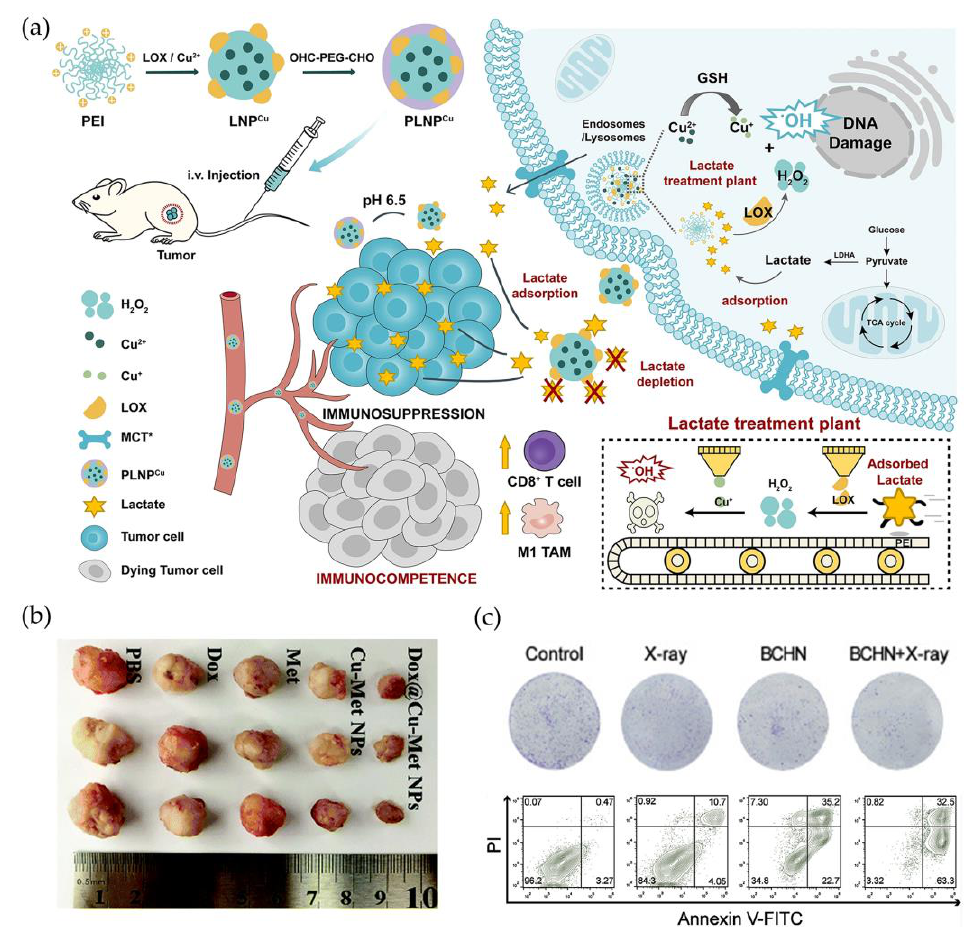
Figure 7. ( a ) Copper transforms lactate-produced H 2 O 2 into antitumor ROS, mediating an immuno- genic cell death. ( b ) Copper-based NPs complex significantly inhibits tumor with good biocompati- bility. ( c ) Copper-based NPs complex reduced the colony-formation rate and cancer cells apoptosis, indicating that BCHN acted as a radiosensitizer. Reprinted with permission from Refs. ( a ) [79] 2021 Springer Nature, ( b ) [82] 2021 Royal Society of Chemistry and ( c ) [83] 2021 Elsevier.